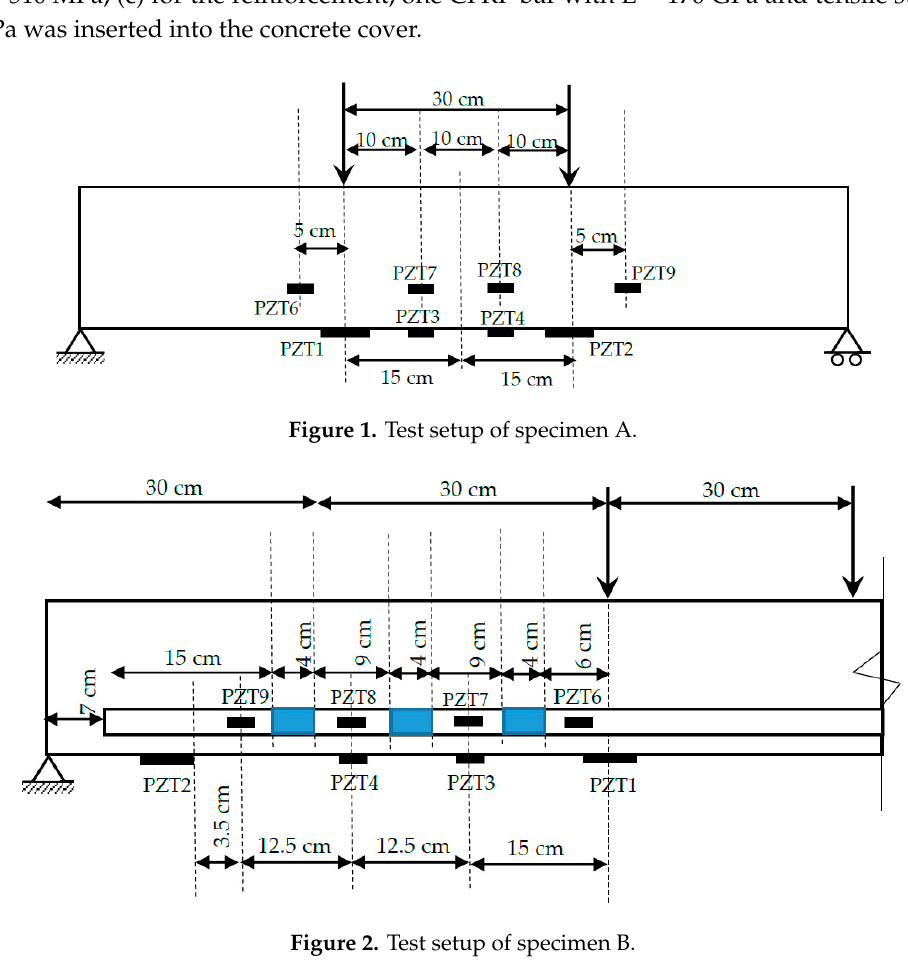
Figure 3. Experimental setup.